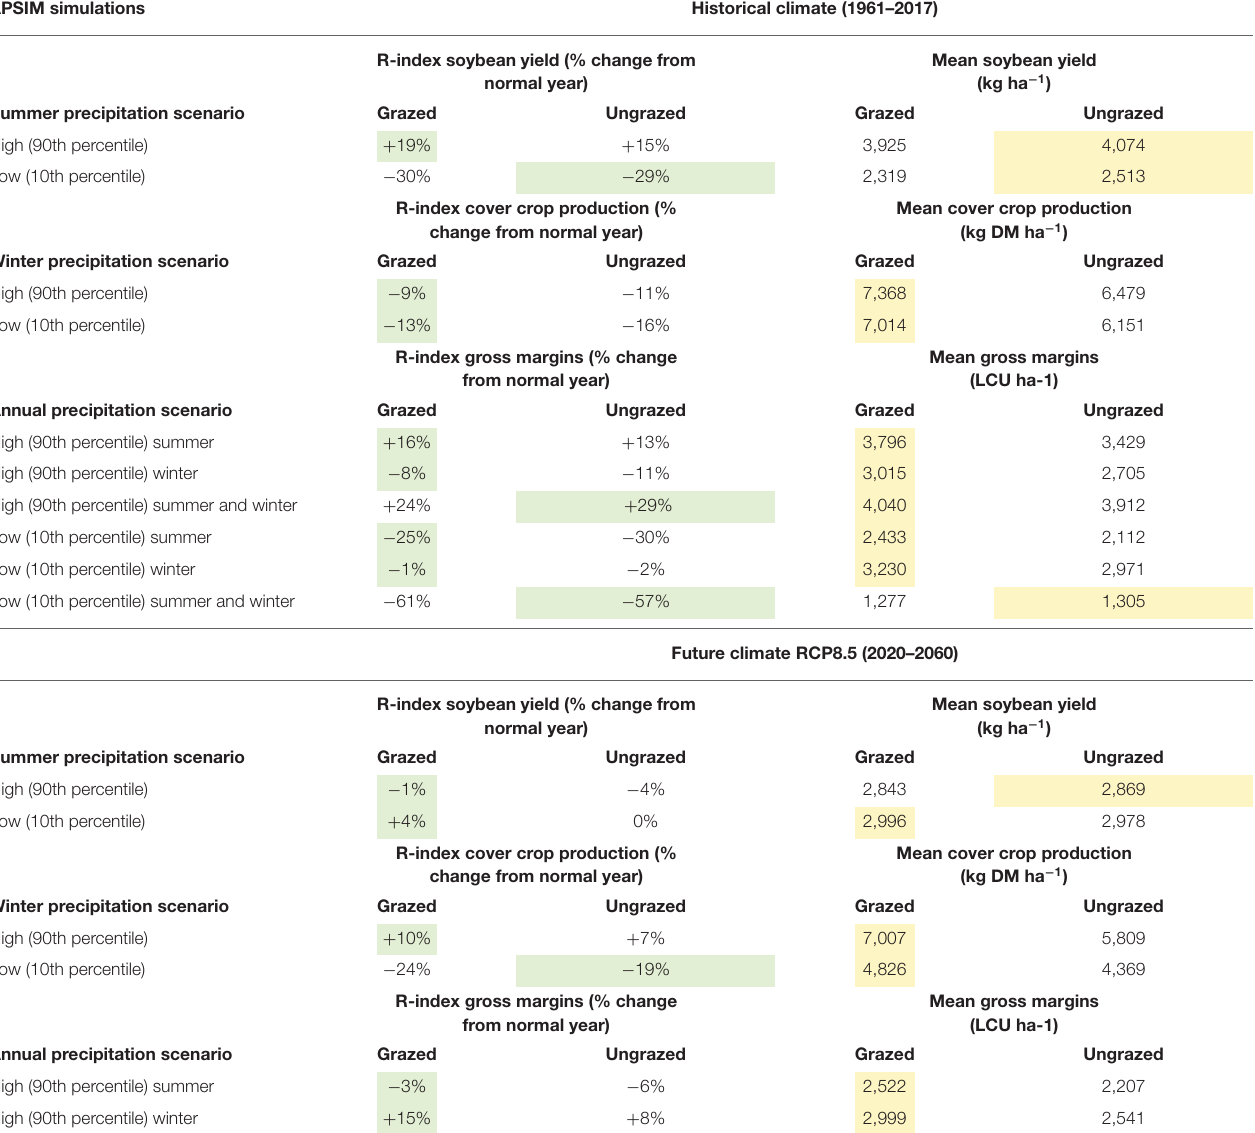
TABLE 2 | R-index and productivity indicators for historical and future climate scenarios simulated in APSIM for a Brazilian soybean-beef integrated system (grazed cover crop) and a specialized control system (ungrazed cover